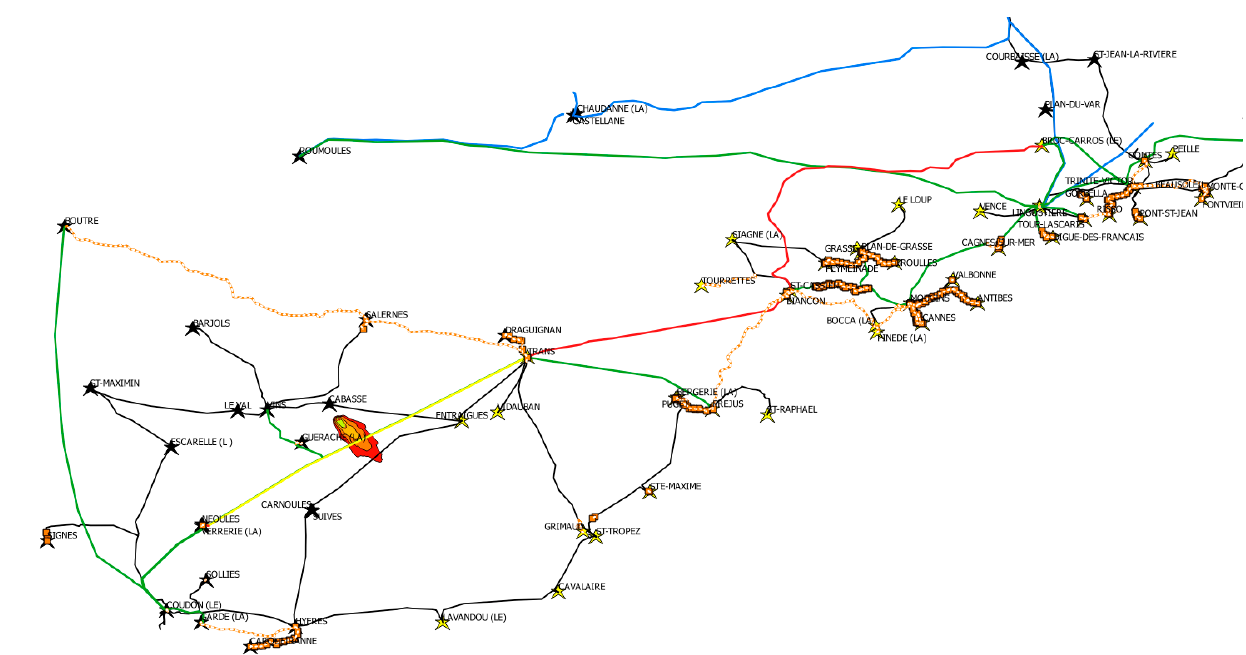
Figure 11. Estimation of electricity network service disruption and cascading effects.